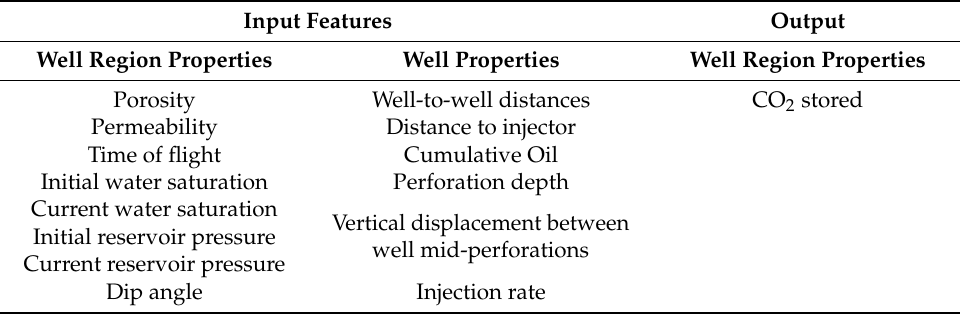
Table 8. Input and output features for the CO 2 storage case.